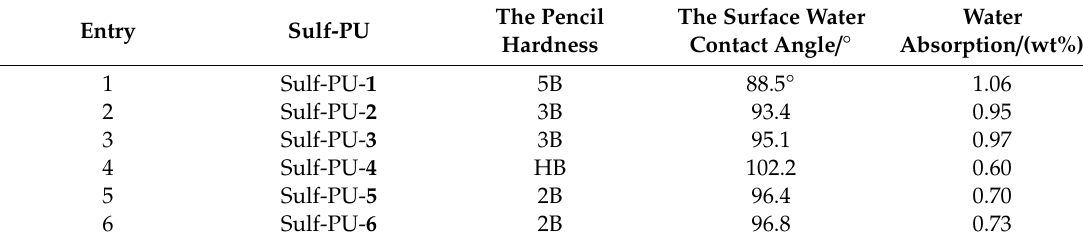
Table 4. The influence of various sulf-PUs on the cure